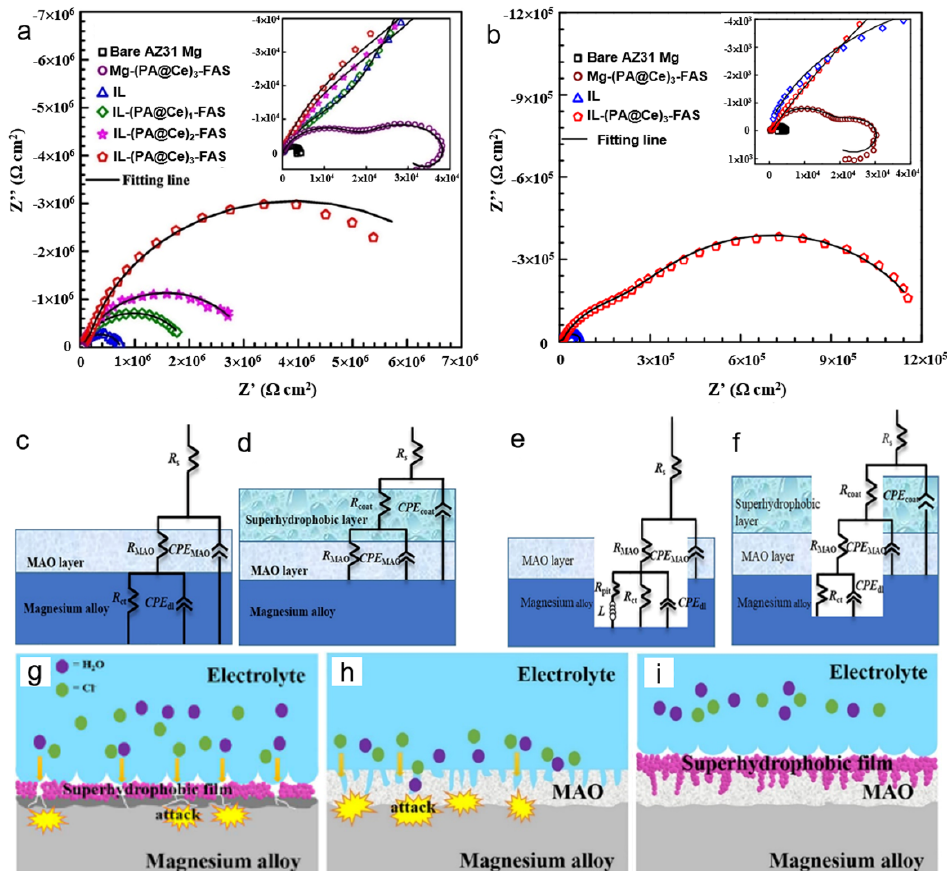
Figure 5. Impedance response showing Nyquist plot of IL-(PA@Ce)-FAS coatings and the bare Mg alloy after 1 h ( a ) and 72 h ( b ) immersion in 3.5 wt% NaCl. The proposed equivalent circuit models of IL and IL-(PA@Ce)-FAS after immersion for 1 h ( c , d ) and 72 h ( e , f ), respectively. A schematic illustration describing corrosion phenomena of metal-(PA@Ce)-FAS ( g ), IL ( h ), and IL-(PA@Ce)-FAS ( i ) was proposed. Reproduced with permission from [31]. Copyright © 2018 Elsevier .